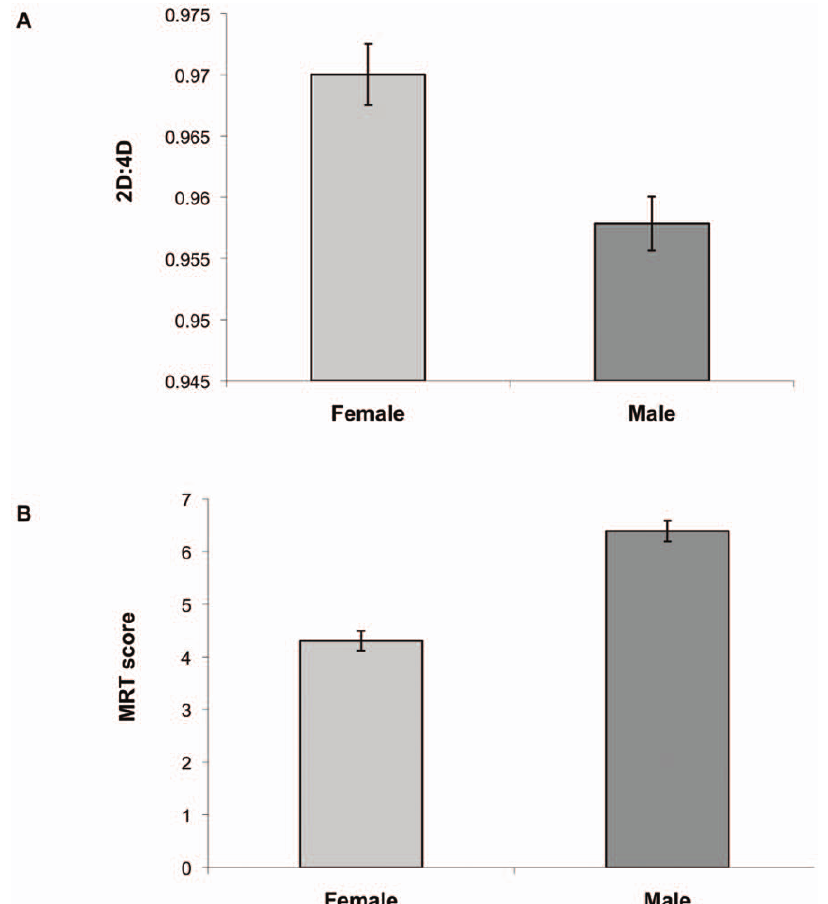
Figure 2. Sex differences in digit ratio (A) and mental rotation score (B). Error bars represent SE.